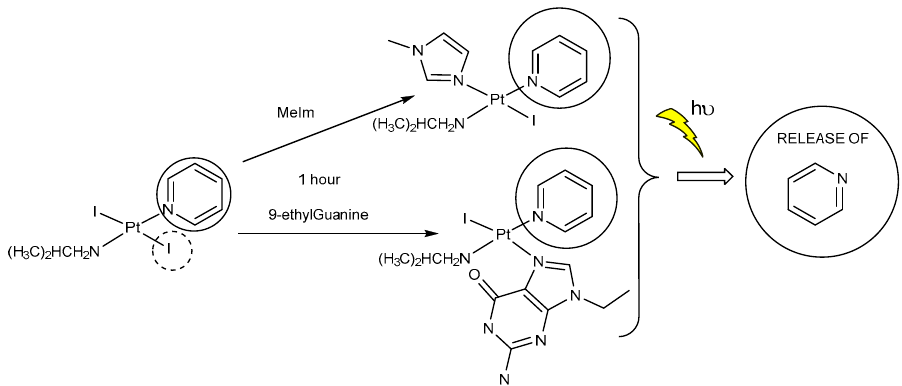
Figure 7. Reactivity versus 9 ‐ EtG and MeIm proposed in the discussion.